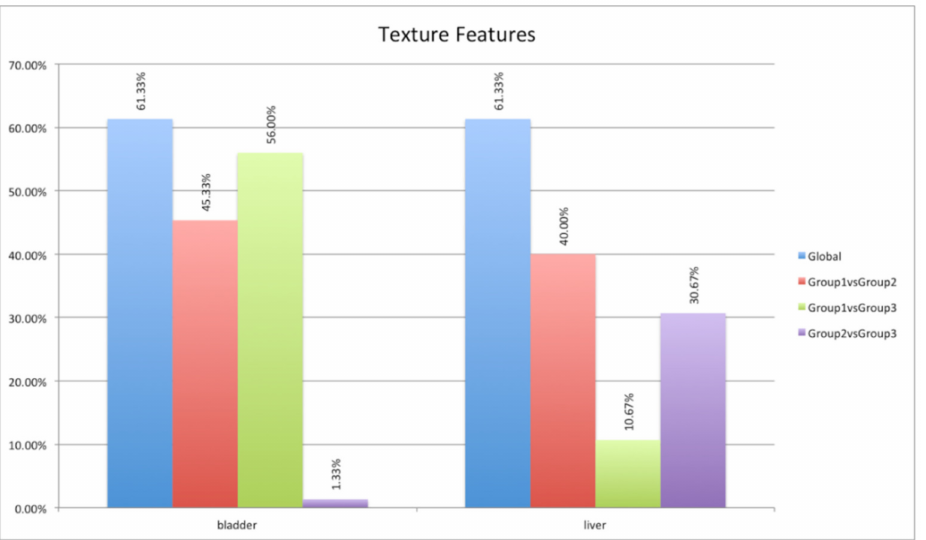
Figure 9. ANOVA and HSD test analyses showing differences in the texture group (75 features) in the three mouse groups (blue column) and differences considering pairs of groups: first group versus second group (red column), first group versus third group (green column), and second group versus third group (violet column).